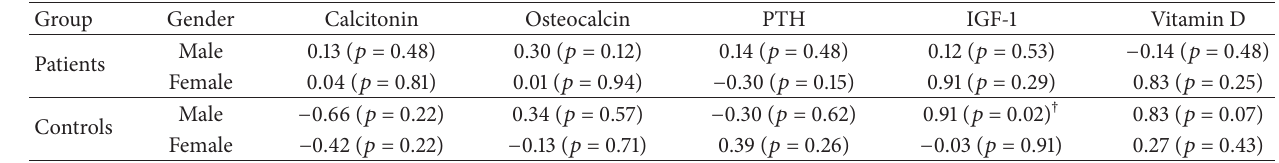
Table 6: Correlation between abdominal lean mass and calcium hormones.